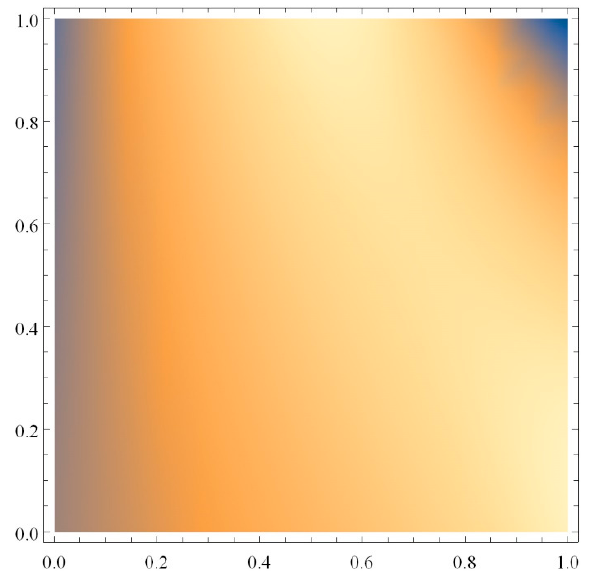
Figure 19 . Density graph of 𝑈(𝑥, 𝑡) versus depth 𝑥 for Equation (45). Figure 19. Density graph of U ( x , t ) versus depth x for Equation